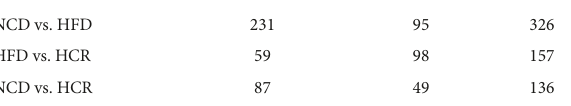
TABLE 2 The summary of DEGs by RNA-seq. Group comparison* Up-regulated Down-regulated Total NCD vs. HFD 231 95 326 HFD vs. HCR 59 98 157 NCD vs. HCR 87 49